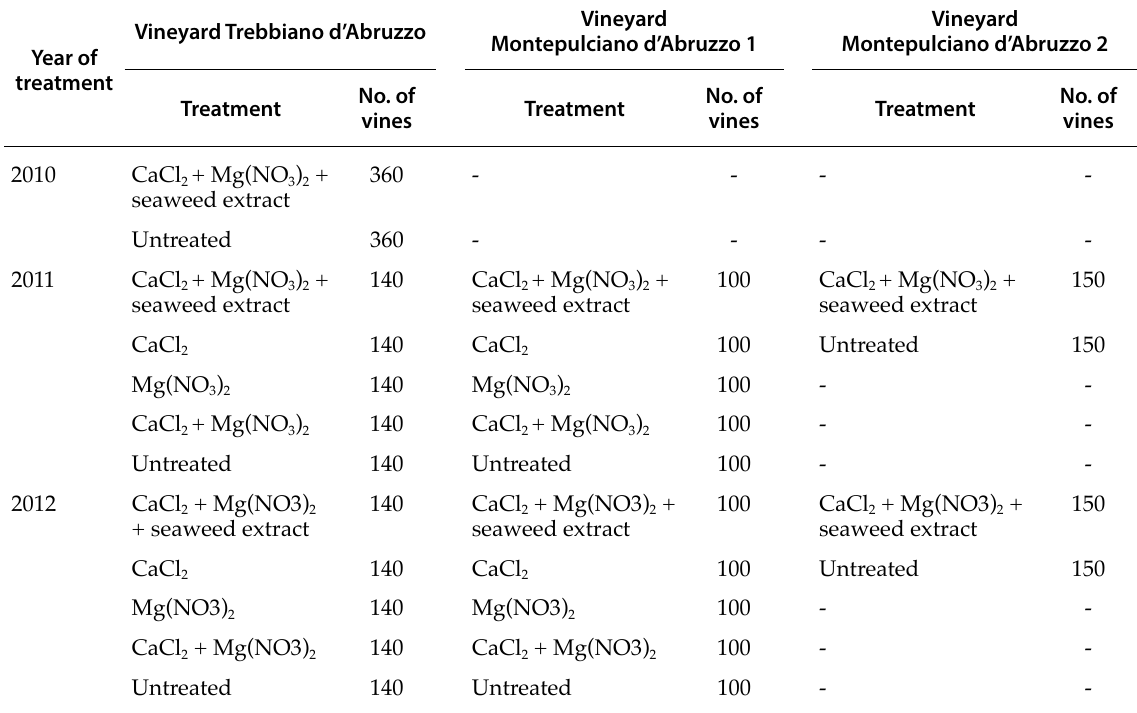
Table 1. Treatment plan applied in 3 vineyards showing GLSD symptoms in the years prior to treatment application.